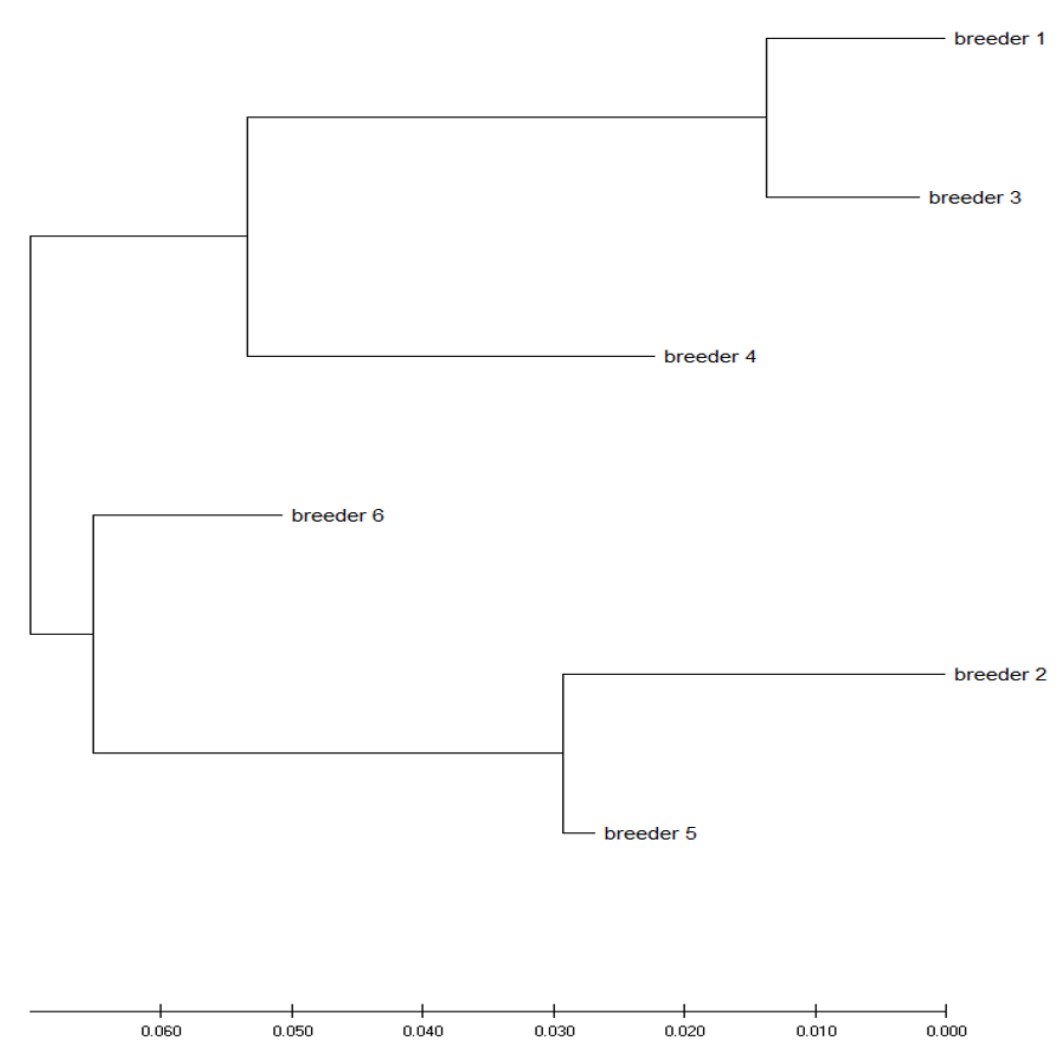
Figure 4. Nei’s distance relationship among breeding groups. The distances were inferred using the Neighbor-Joining method. The optimal tree with the sum of branch length = 0.19997414 is shown. The tree is drawn to scale, and its branch lengths use the same units as those of the evolutionary distances used to infer the phylogenetic tree.